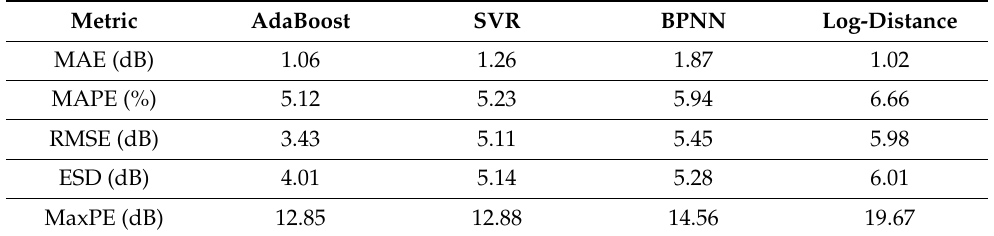
Table 2. Performance evaluation of various models using 20% test samples from FUTA FM (93.1 MHz) Base Station.